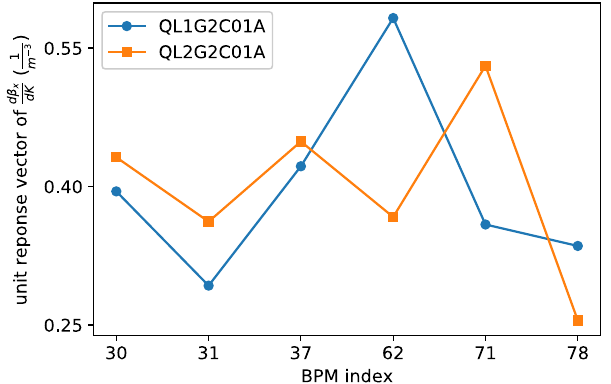
FIG. 4. The unit β x responses vectors of quadrupole 10 and 11 seen at six selected BPMs. They are near orthogonal in the 6D vector space because their correlation calculated with Eq. (17) is as low as 0.0612.